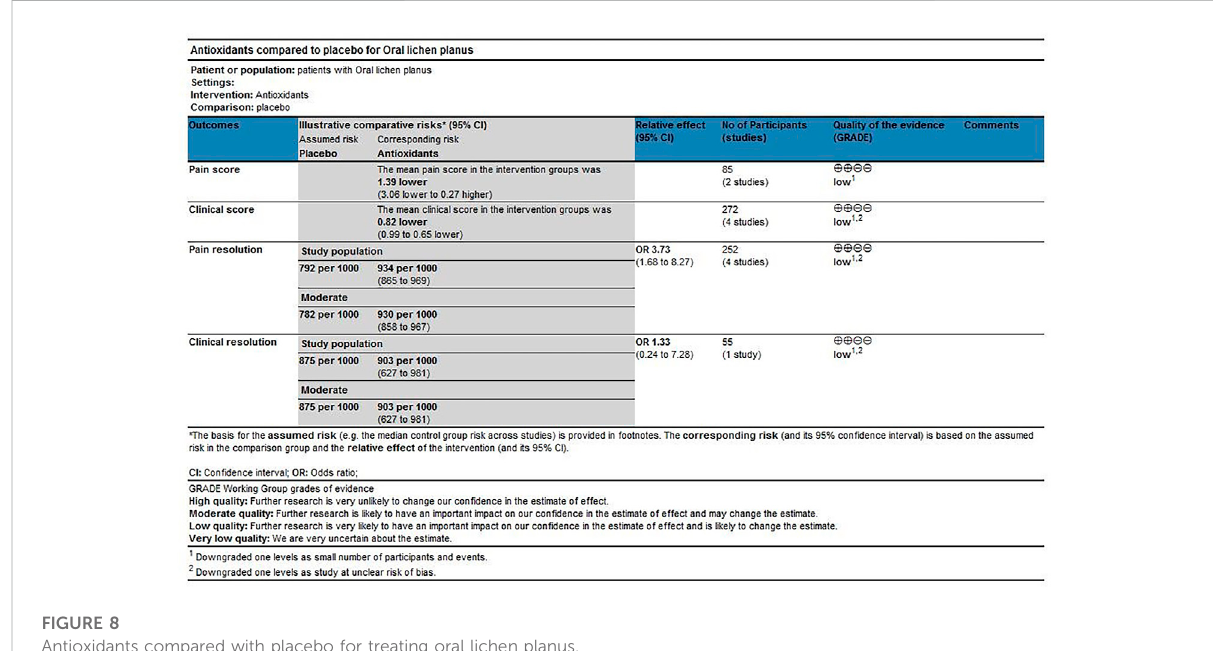
FIGURE 8 Antioxidants compared with placebo for treating oral lichen